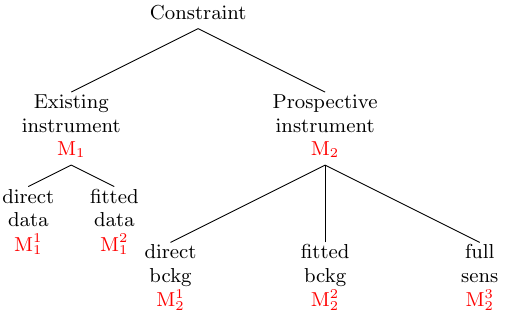
Fig. 1 The different constraint methods. We have restricted the tree to methods we have encountered in the literature: for existing instruments, “direct data” means that the instrument data points are used, and “fitted data” that a fit running through the data points is chosen; for prospective instruments, “direct bckg” means that the data points used as agnostic background, “fitted bckg” that some fit is used and “full sens” that pre- existing data are ignored and the new detector maximal sensitivity is used. The designation we use in the text are: “type 1” methods M 1 with sub-methods M 1 and M 2 for existing instruments; “type 2” 1 1